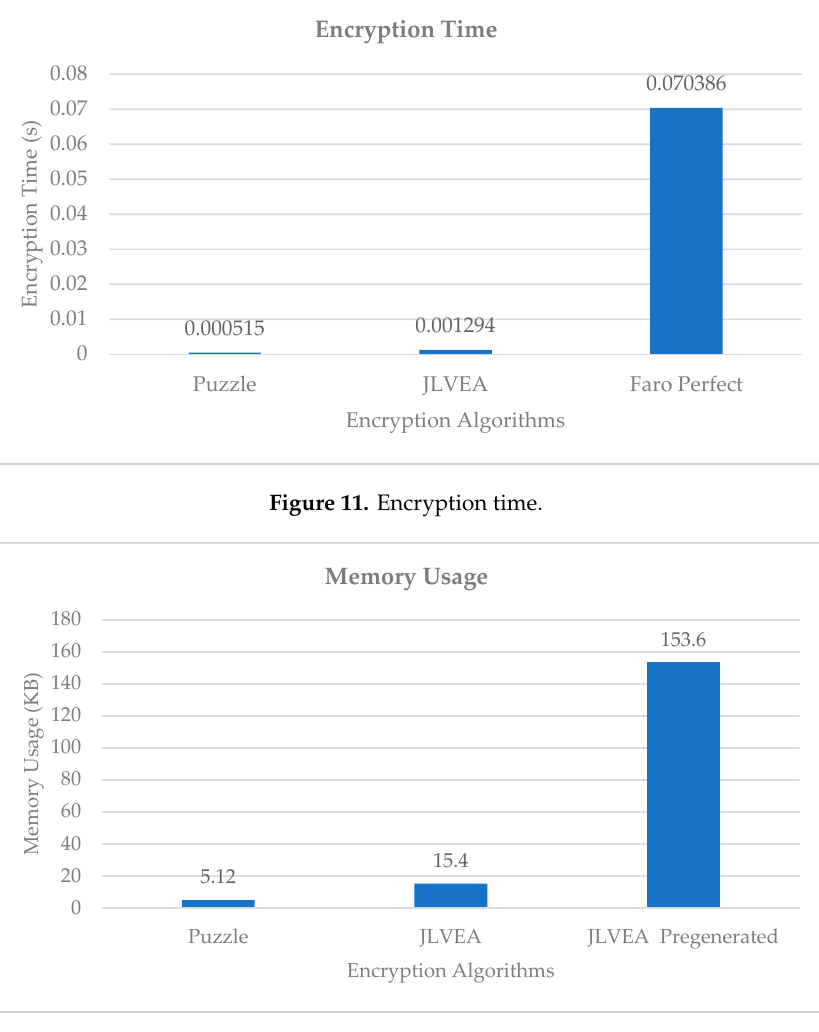
Figure 12. Memory usage.